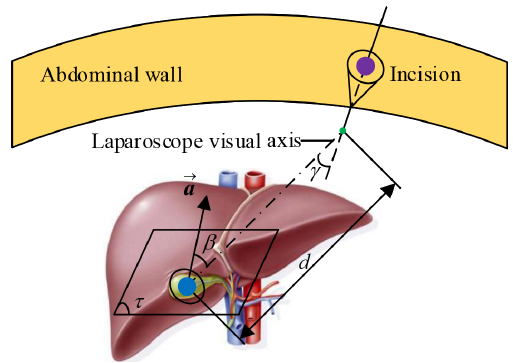
Figure 5. The definition of lesion parameters.